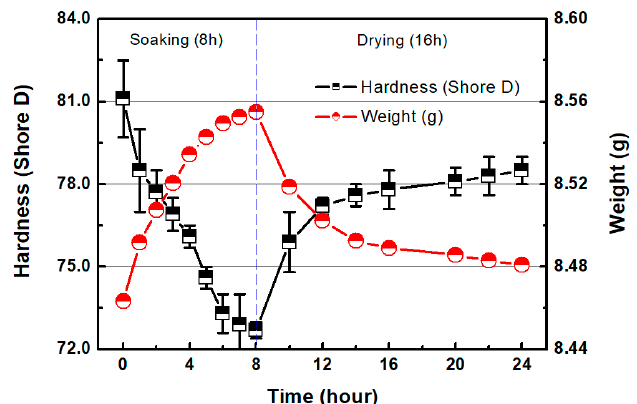
Figure 3. Hardness and weight of SLA 3D-printed ABS-like resin as functions of soaking and drying